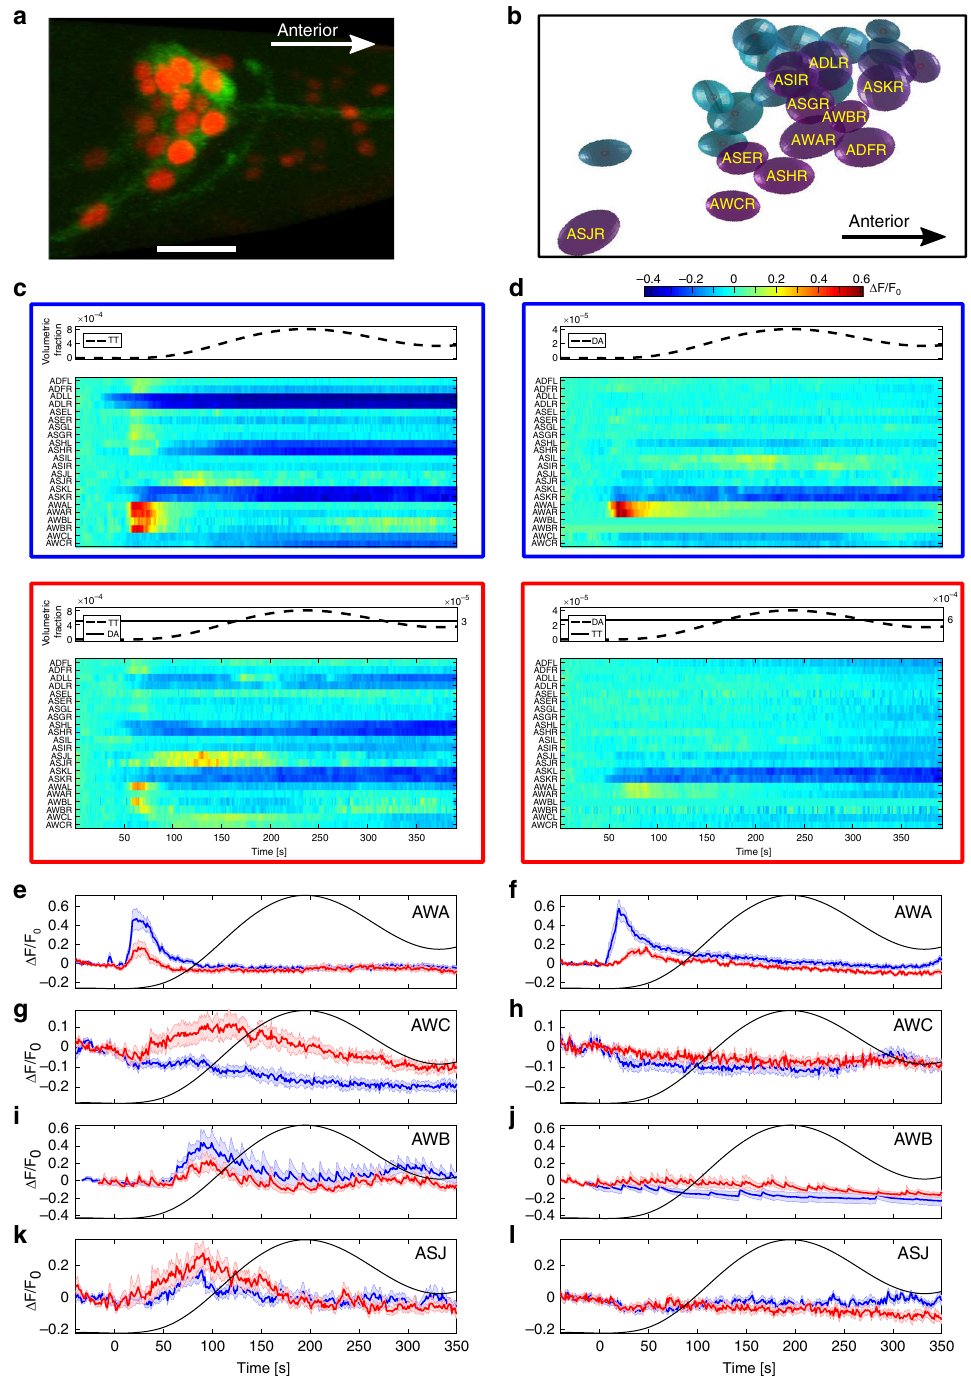
AWA-speci fi c DA receptor 12,13,18 . Both odr-10 mutants displayed normal attraction to TT, but in contrast to wild-type animals, this attraction remained intact and did not switch to repulsion in the background of DA (Fig. 6d). These fi ndings indicate that DA modulates the attraction to TT through its action on the ODR-10 GPCR in the AWA neurons. Moreover, it suggests that TT sensation in the AWA neurons is mediated through a different receptor than ODR-10, as odr-10 mutants were still attracted to TT (Fig. 6d). The neuroimaging analyses (Fig. 5), together with the results obtained by behavioral assays of mutant strains (Fig. 6a – d), offer